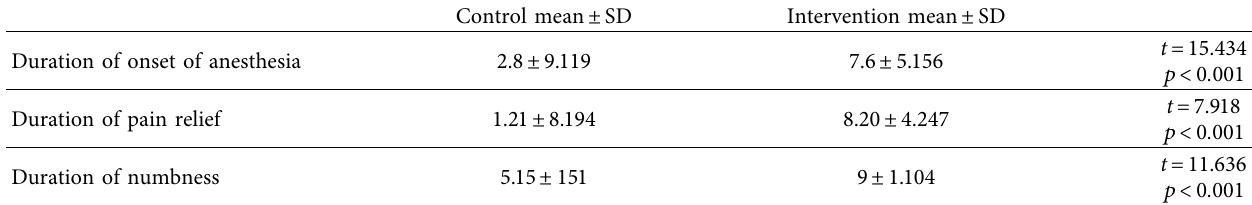
Table 1: Comparison of frequency distribution of the movement type, sensory block and painkiller dose.